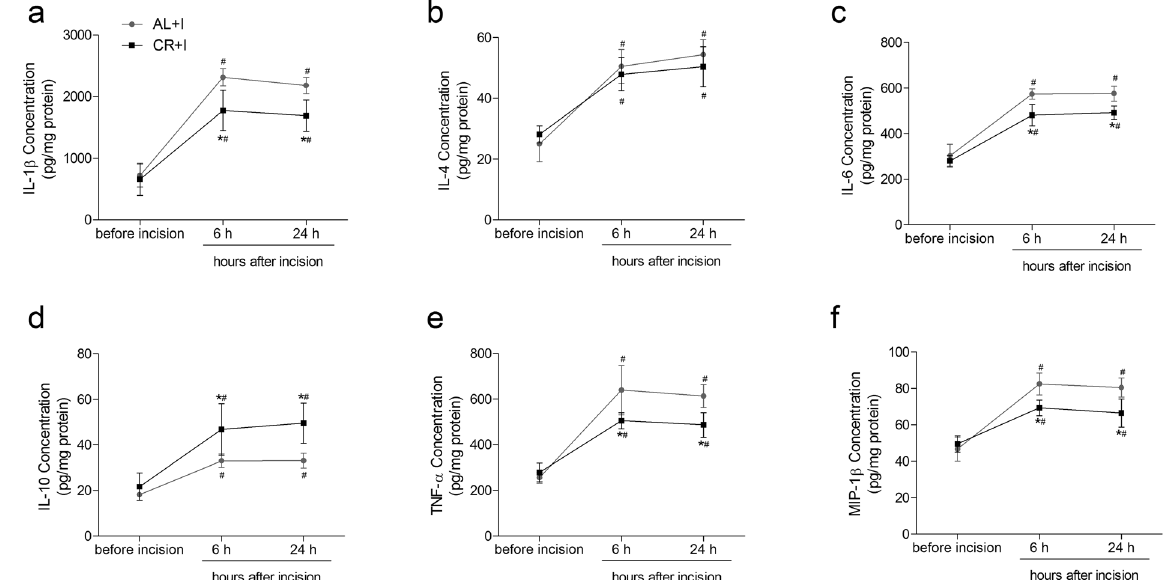
Figure 5. Effects of caloric restriction on pro-inflammatory and anti-inflammatory cytokines in peri-incisional skin tissue after incision. Levels of IL-1 β ( a ), IL-4 ( b ), IL-6 ( c ), IL-10 ( d ), TNF- α ( e ) and MIP-1 β ( f ) in peri- incisional skin tissue (pg/mg protein) measured before, 6 h, and 24 h after incisional surgery (n = 5). Values expressed as mean ± SD. The treatment style was same as described in Fig. 1. Significant difference was revealed after two-way ANOVA ( * P < 0.05 in comparison of group CR + I with group AL + I, # P < 0.05 compared with baseline, Bonferroni post hoc tests).